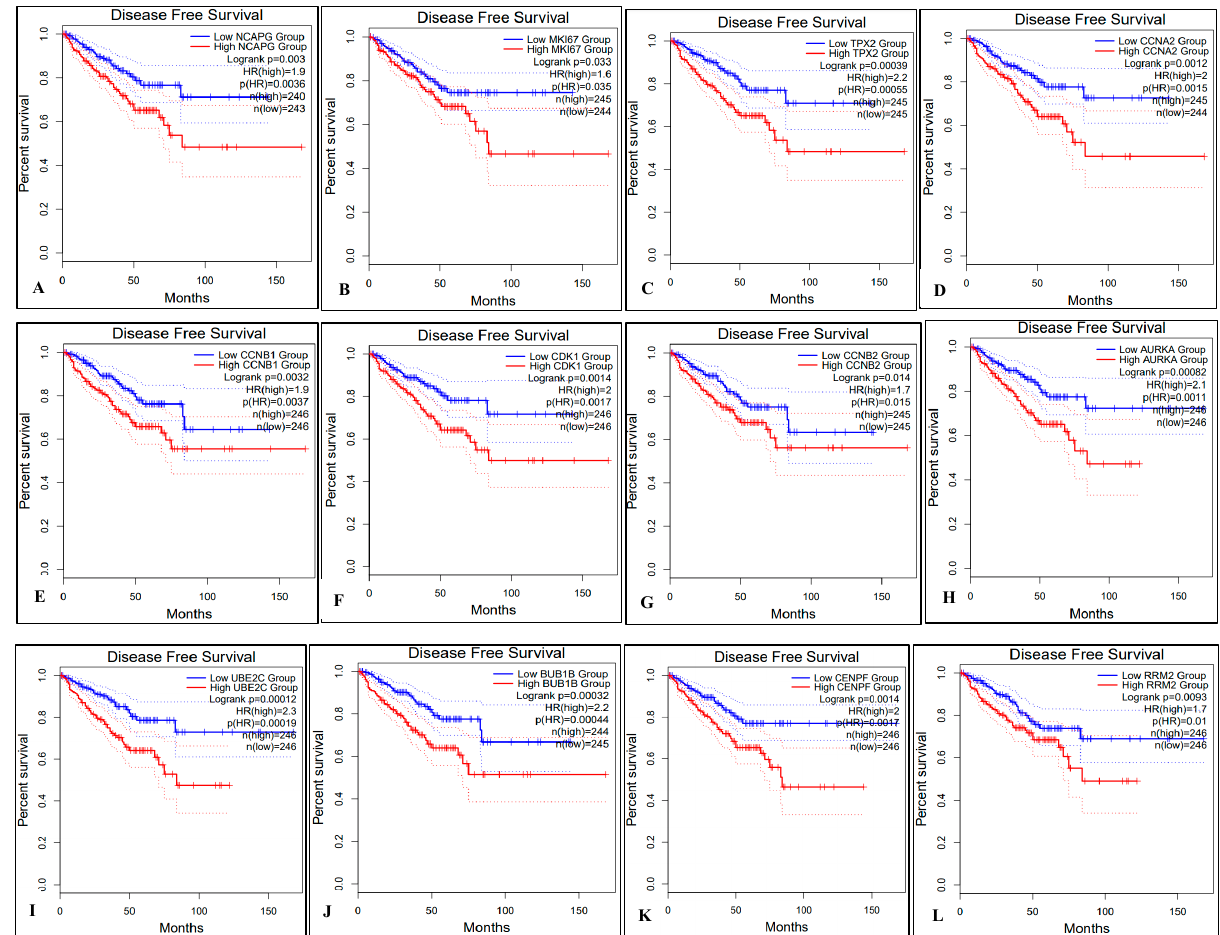
Figure 9. Prognostic survival analysis of DFS based on the high or low expression of 12 hub genes from TCGA in PCa patients was performed using GEPIA. OS analysis for 5 up-regulated ( A – E ) and 7 down-regulated ( F – L ) genes is presented. The dotted line on both sides of the curve represents the 95% confidence interval (95% CI), and log-rank p < 0.05 is considered as a statistically significant value. The red and blue lines represent high and low expressions of individual Hub genes ( A – L ), respectively in the PCa patient samples compared to the normal tissues.